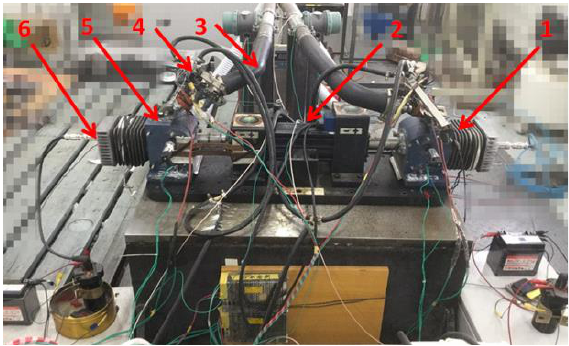
Figure 9. The physical prototype of the FPGLG. 1. The cylinder; 2. The LEM; 3. Air-intake system;